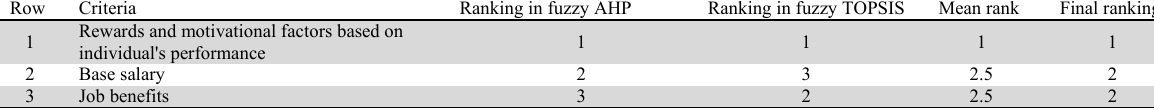
The results of final ranking of compensation system